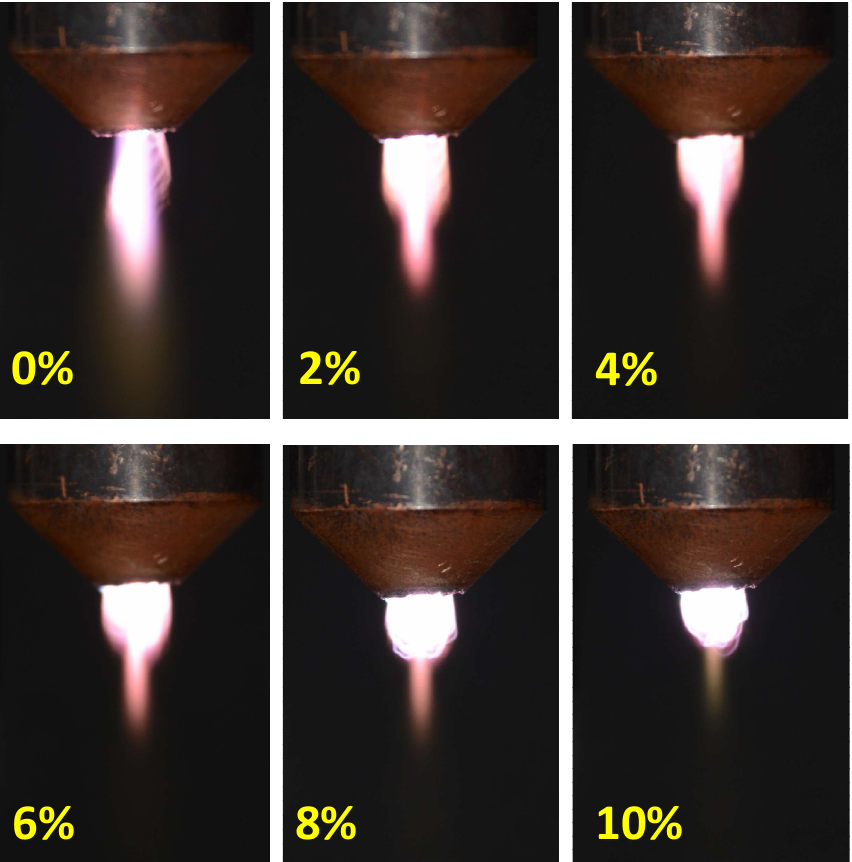
Figure 6. The influence of the hydrogen percentage (as depicted in the pictures of [43]) in the nitrogen– hydrogen gas mixture on the plasma jet with no arc transfer in free space. Conditions: total gas flow 60 SLM, frequency 62 kHz, power